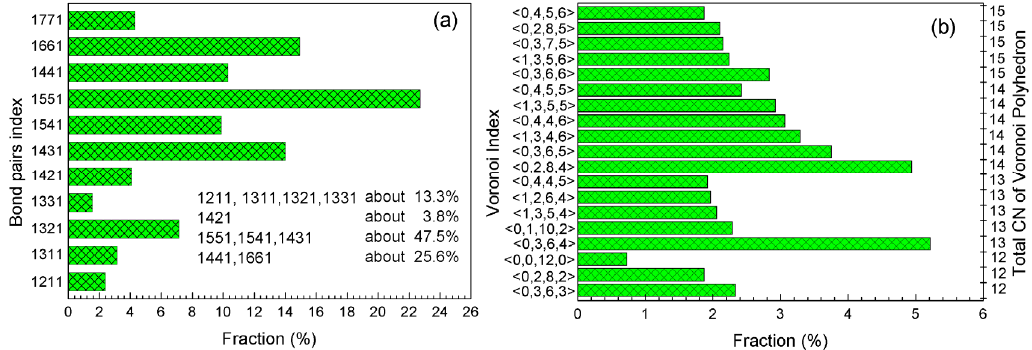
Figure 3. ( a ) Distribution of bond pairs in RMC configuration. The summation of some bond pairs is listed in the inset table down right; ( b ) Average frequencies of Voronoi polyhedra. Table 1. The total percentage of bcc ‐ and ico ‐ type polyhedra in Zr 48 Cu 36 Al 8 Ag 8 BMG. Polyhedron Type